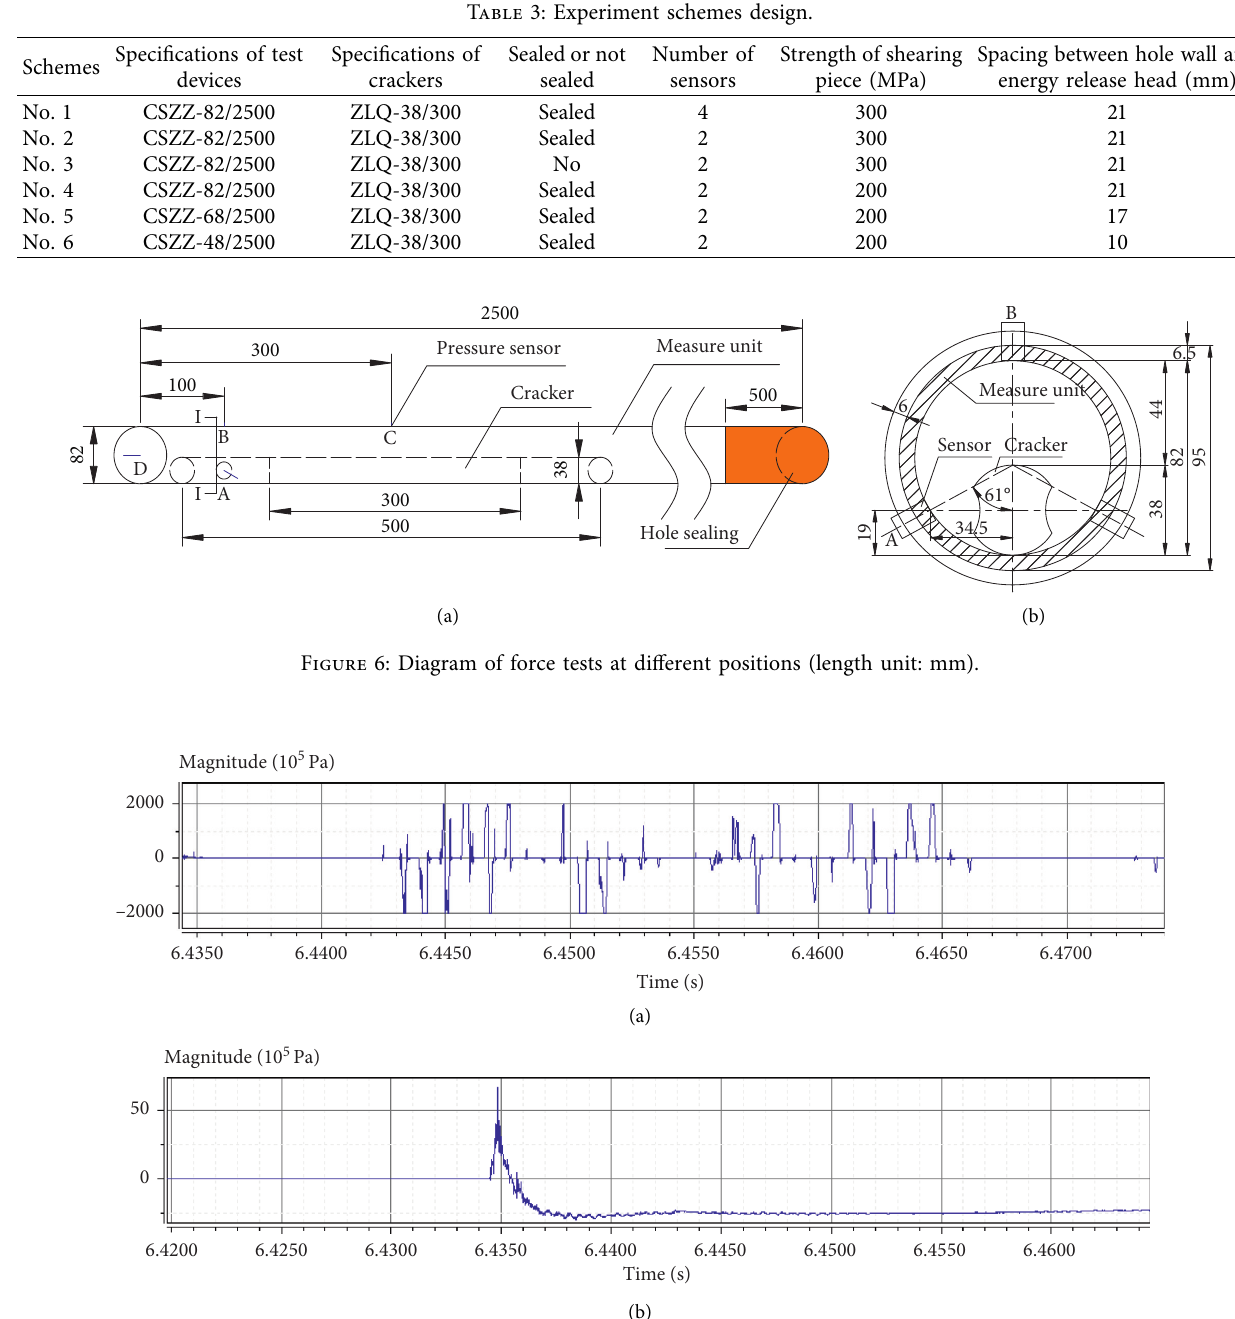
Table 2: Specifications and parameters of liquid CO